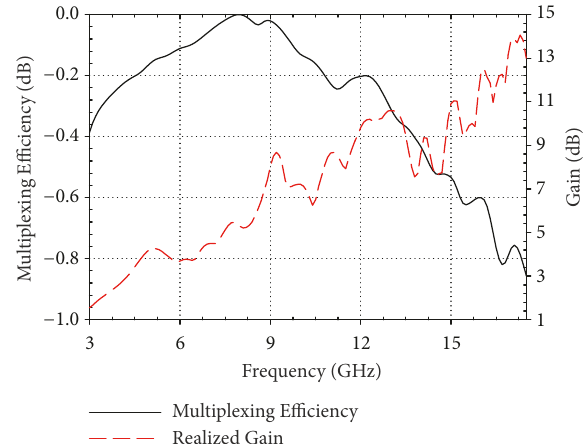
Figure 9: Realized gain and multiplexing efficiency of the proposed